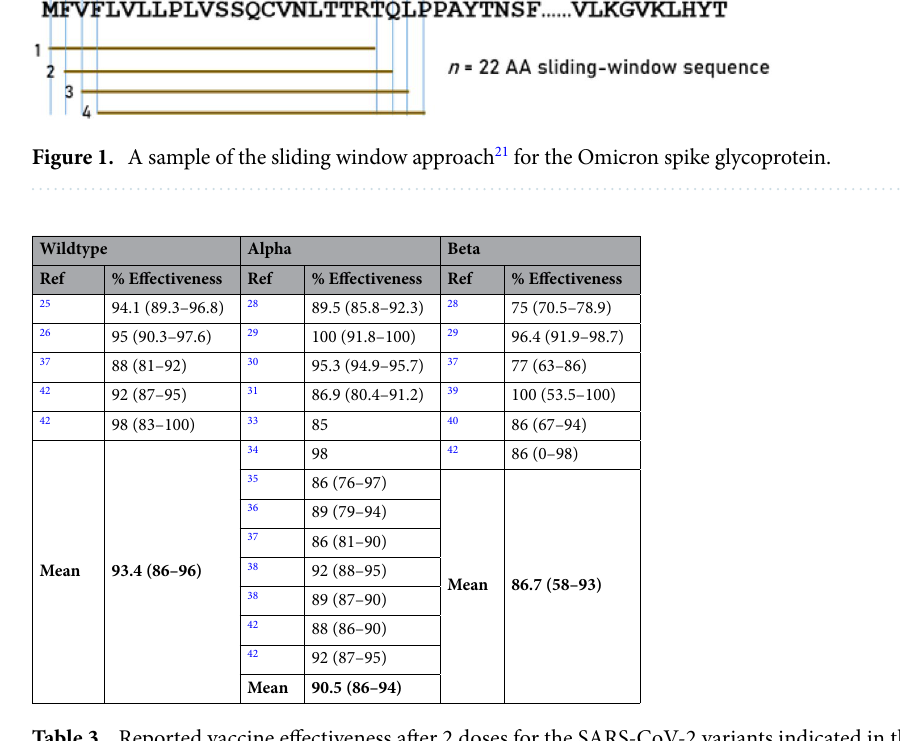
Table 3. Reported vaccine effectiveness after 2 doses for the SARS-CoV-2 variants indicated in the table. Parentheses are 95% CI (if given in the study). Numbers in bold are means of vaccine effectiveness and 95%